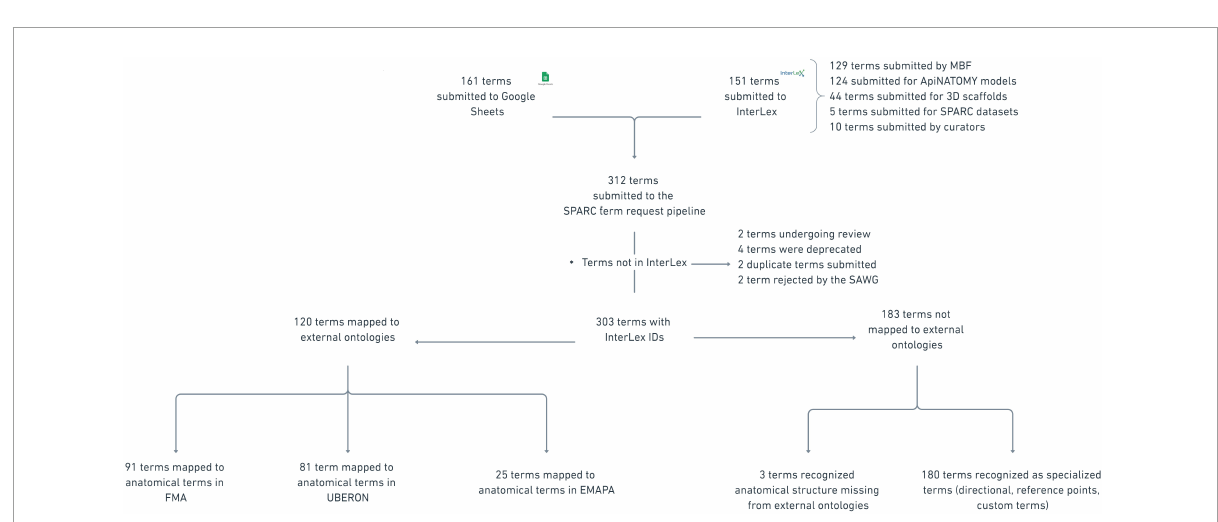
FIGURE7 SPARC term request workflow. Flow chart illustrating the term request and review steps of the term request